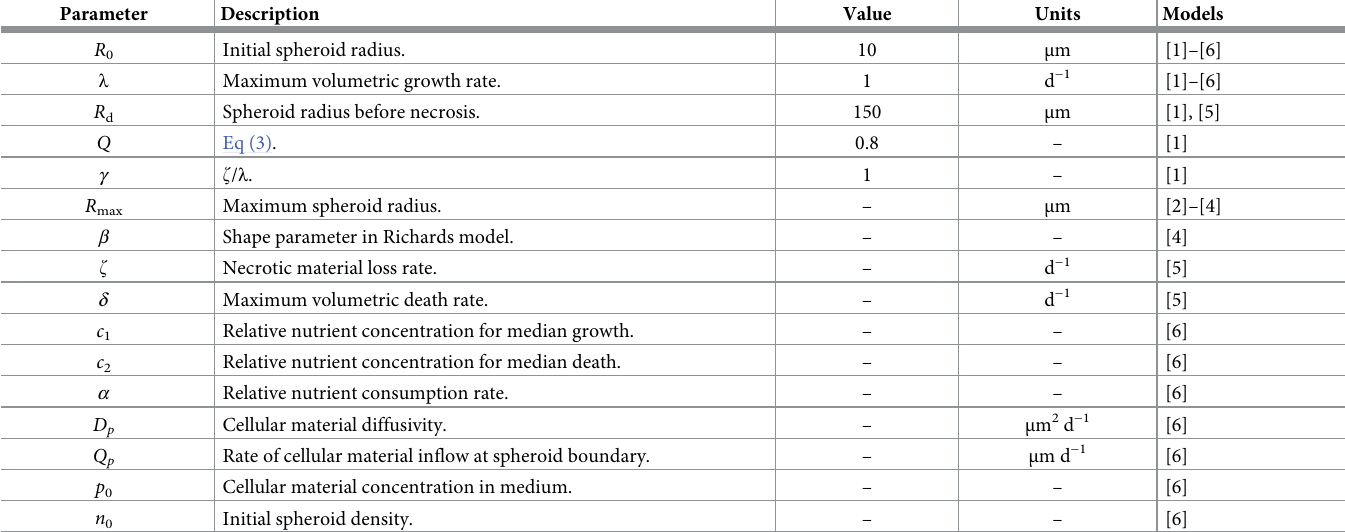
Table 1. Summary of model parameters. Synthetic data are generated using the Greenspan model, with parameters λ , R d , Q , and γ . Parameters in all other models are chosen as the parameter set that gives the closest match to synthetic data from the Greenspan